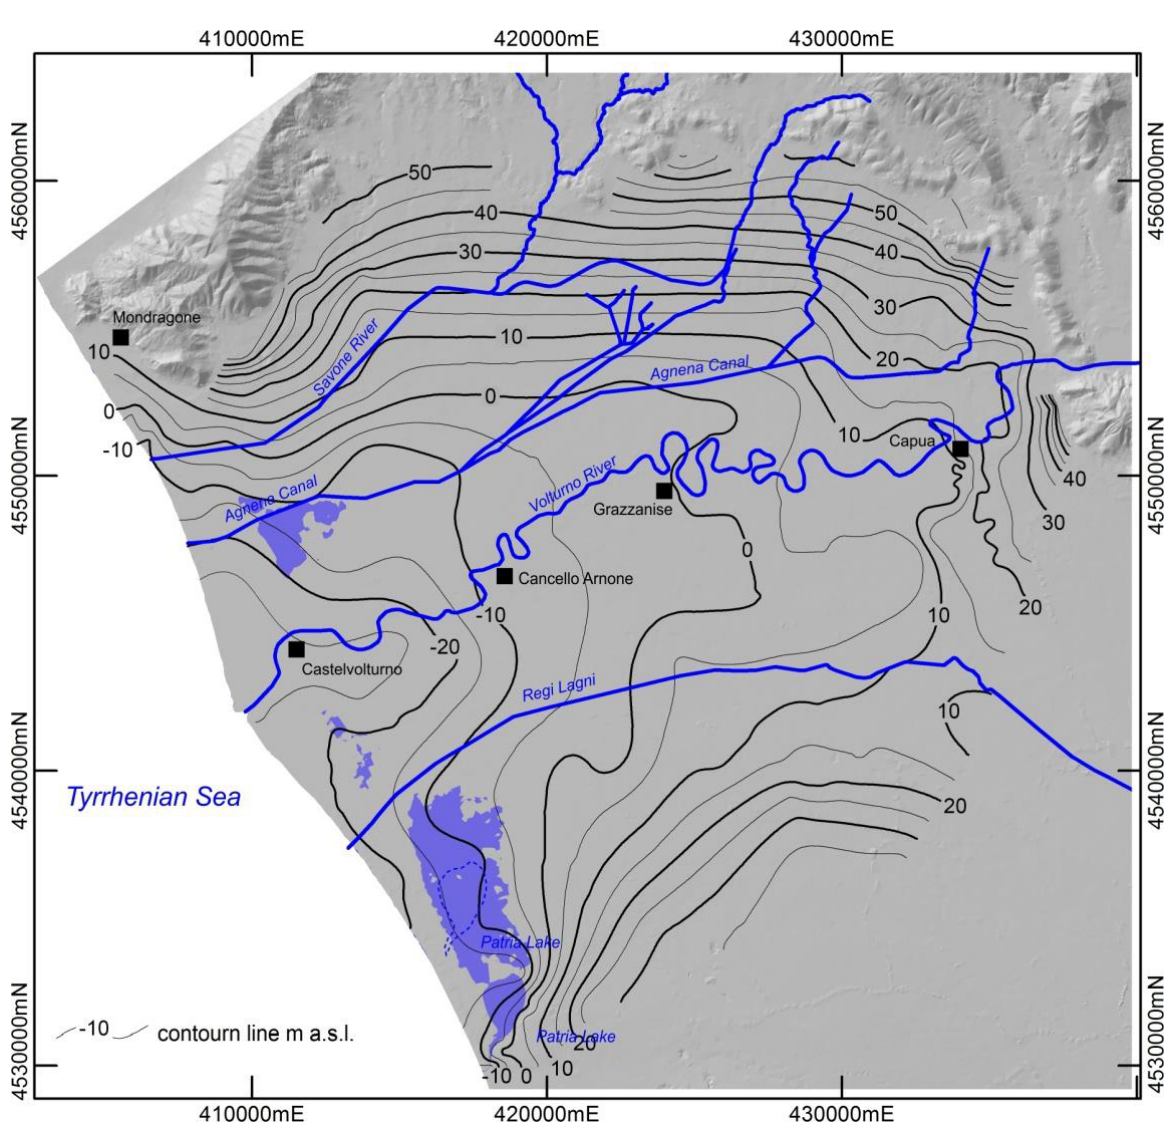
Figure 4. Contour map of the upper surface of the CGT. A valley morphology is evident along the present Volturno River course and the Regi Lagni canal (previously Clanio River).